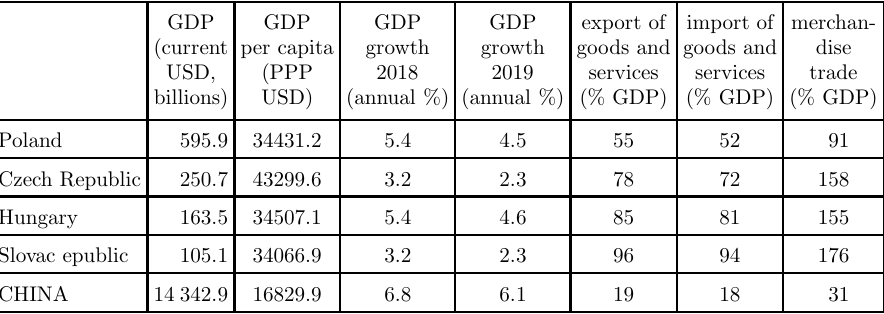
GDP and foreign trade (% GDP) in V4 and China, 2019 GDP GDP GDP GDP export of import of merchan- (current per capita growth growth goods and goods and dise USD, (PPP 2018 2019 services services trade billions) USD) (annual %) (annual %) (% GDP) (% GDP) (% GDP) Poland 595.9 34431.2 5.4 4.5 55 52 91 Czech Republic 250.7 43299.6 158 Hungary 163.5 34507.1 4.6 85 81 155 Slovac epublic 105.1 34066.9 3.2 2.3 96 94 176 CHINA 14 342.9 16829.9 6.8